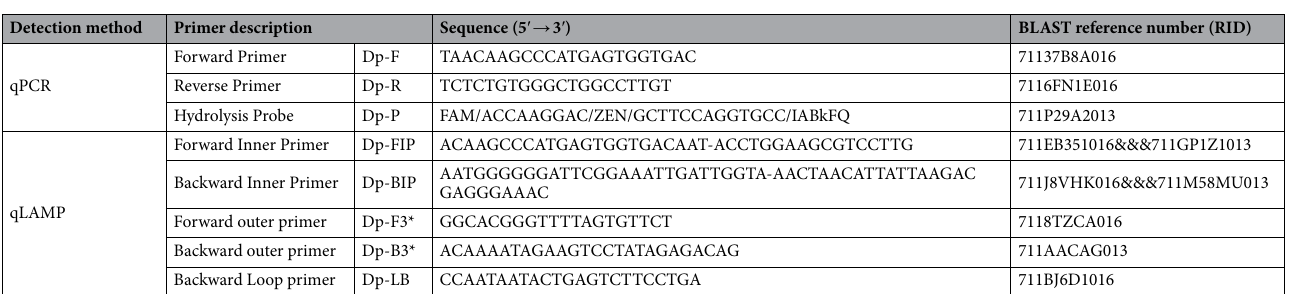
Figure 5. Consensus sequence obtained from the alignment of 40 COI gene sequences from D. polymorpha retrieved from GenBank, and aligned with the CLC Sequence Viewer 7.7 software (CLC Bio-QIAGEN, Aarhus, Denmark).